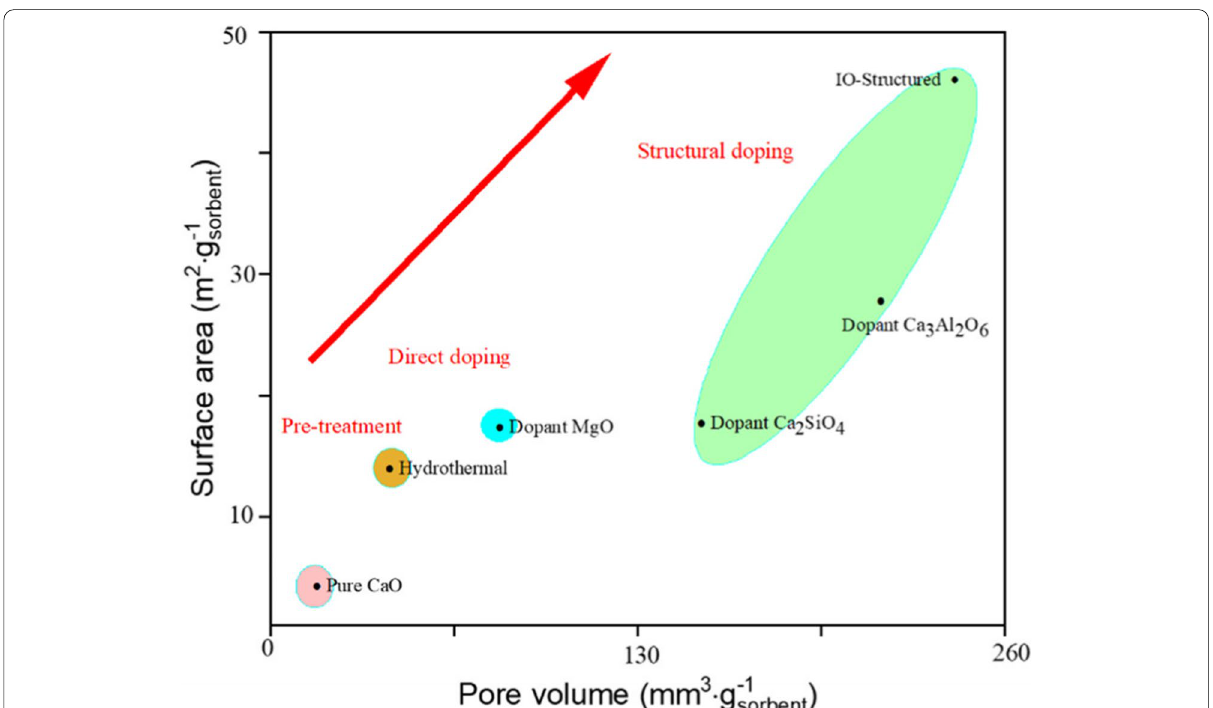
Fig. 15 Schematic of the AEMOs-based sorbent structure design strategies based on surface area and volume